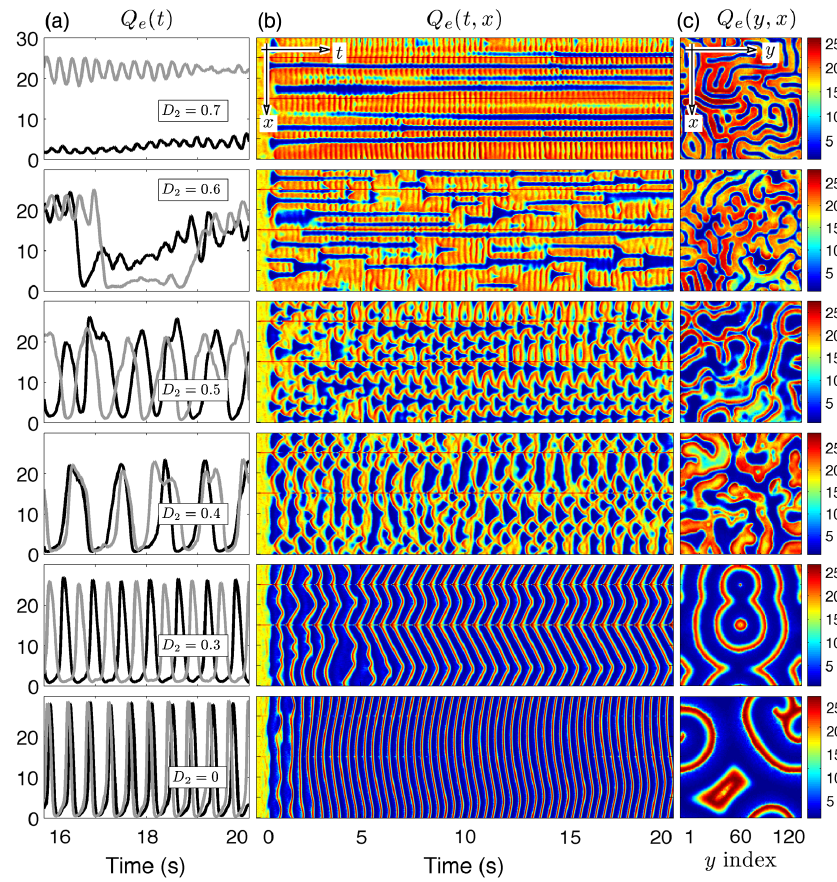
FIG. 5. Effect of inhibitory diffusion on wake state. Grid simulations, initialized at the high-firing wake state of Fig. 3, show dynamical effect of stepped reductions in diffusion strength from D 2 ¼ 0 : 7 cm 2 (top row) to D 2 ¼ 0 (bottom). (a) Time-series extracts showing excitatory firing rates Q e ð t Þ for the final 4 s of a 20-s run at x ¼ 30 ( black lines), x ¼ 85 ( gray lines) on the midline ( y ¼ 60 ) of the 120 (cid:1) 120 cortical grid. (b) Q e ð t; x Þ space-time strip charts showing x -axis activity along the y ¼ 60 midline strip for a full 20-s simulation. (c) Q e ð y; x Þ bird’s-eye view of cortical activity at t ¼ 20 s ; the color bar indicates the firing rate in spikes/s. Simulation settings: toroidal boundary conditions; integration time step (cid:1) t ¼ 0 : 4 ms . Stimulus: spatiotemporal white noise with scale factor 20 to x 60 on the y ¼ 60 (cid:4) ¼ 4 ; direct two-way connection joins x 1 ¼ 2 ¼